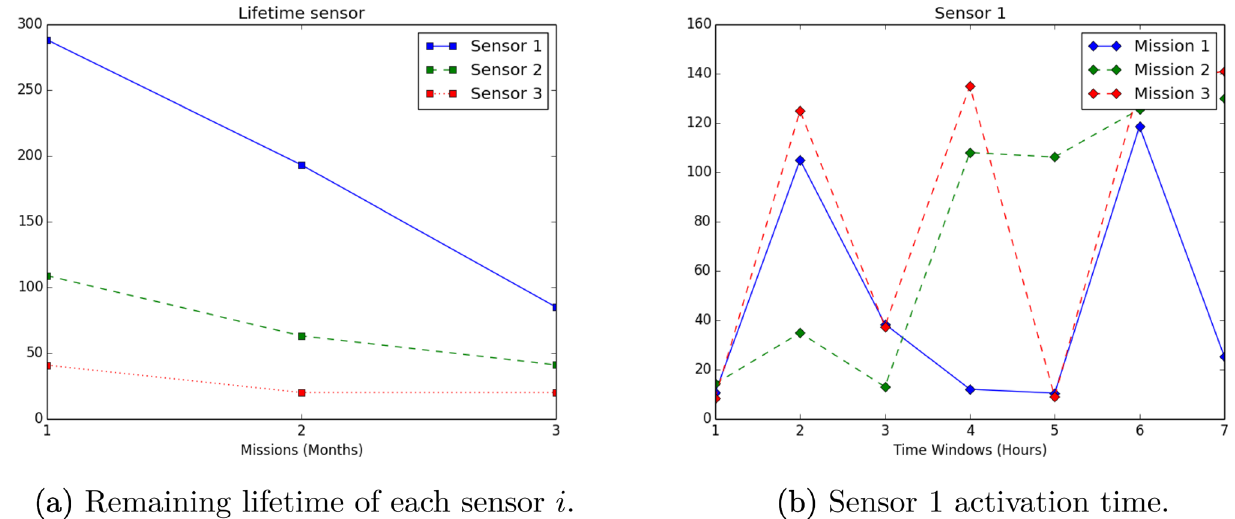
Fig. 5 Scheduling the activation of a sensor i